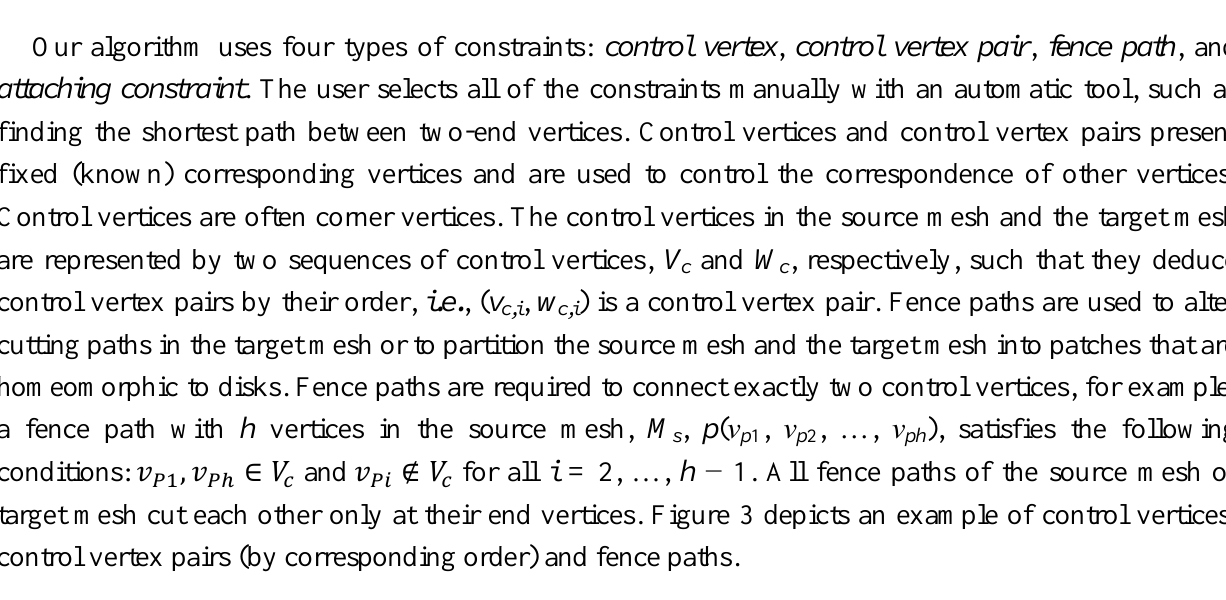
Figure 3. An example of control vertices, control vertex pairs and fence